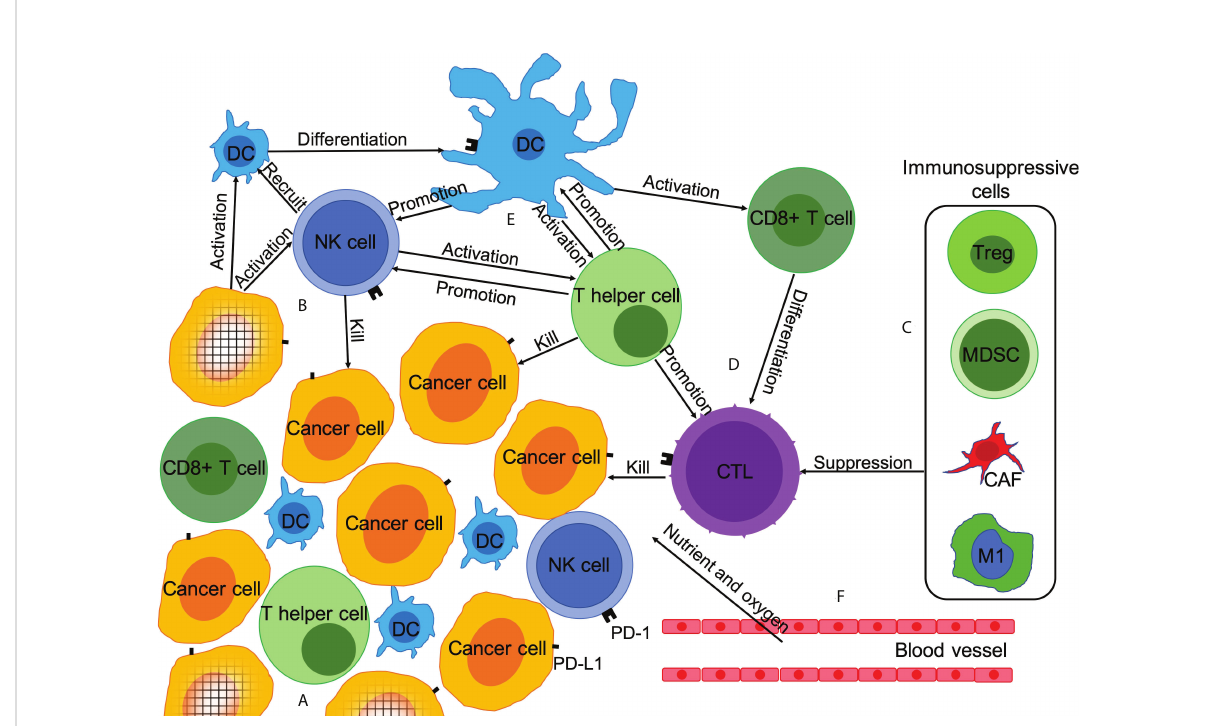
FIGURE 1 Microenvironment of tumor immunity and mechanism of chemotherapy promoting anti-tumor immune response. Anti-tumor immune response is a complex process, which is affected by the dynamic balance between immune-promoting factors and immunosuppressive factors. Chemotherapy can affect the anti-tumor immune response in at least six ways. (A) Reduction in the number of tumor cells; (B) Promotion of immunogenic tumor cell death; (C) Depletion of immunosuppressive cells; (D) Increase in the number and activity of anti-tumor immune effector T cells; (E) Enhanced expression of PD-L1 and secretion of anti-tumor immune cytokines; (F)